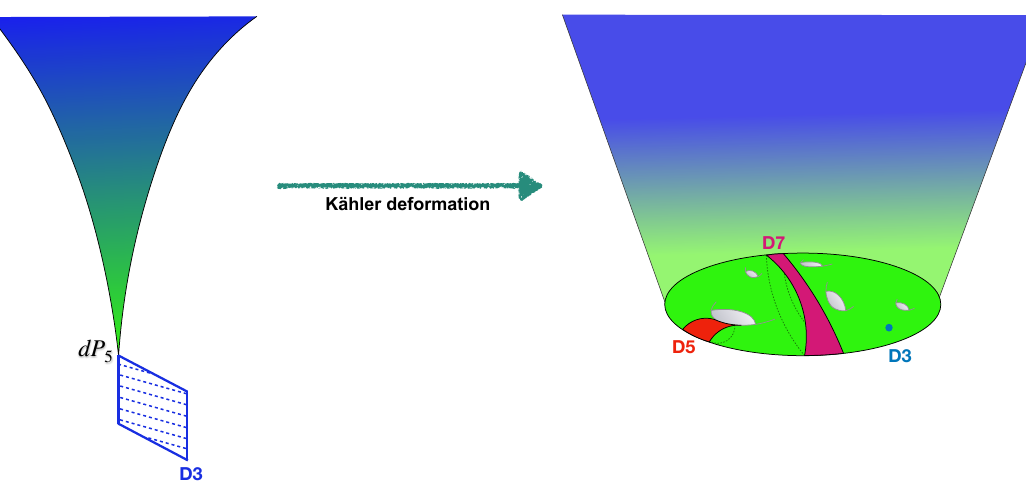
Figure 2 . The splitting of a D3-brane at a del Pezzo singularity into fractional branes by considering the large volume limit of the corresponding 4